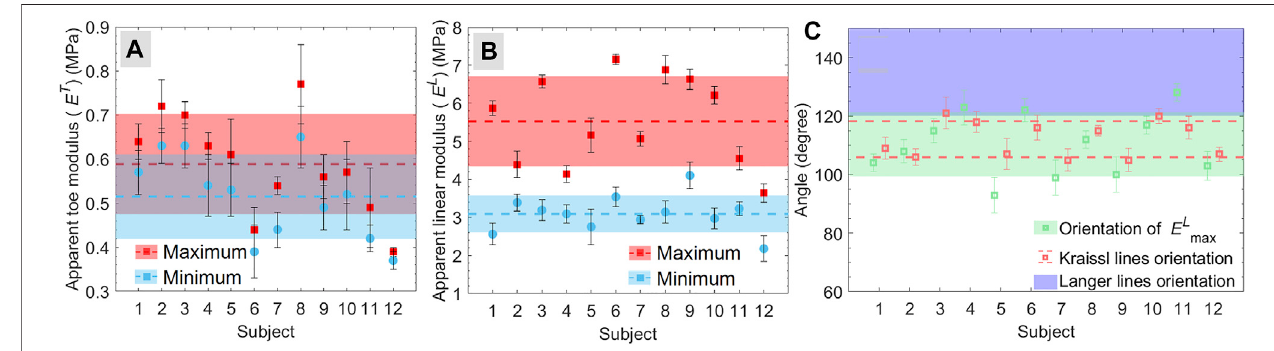
FIGURE5|(A,B) maximumandminimumapparentmodulusfor (A) toeregionand (B) linearregioncalculatedforindividualsubjects.Thedashedlinesandshaded regionswiththesamecolorrepresentthemeanandstandarddeviation,respectively,fortherespectivevalues. (C) themaximumlinearmodulusorientationanddirection of Kraissl ’ s lines. The blue shaded region (in C) represent the estimated range of Langer lines (Langer, 1861).